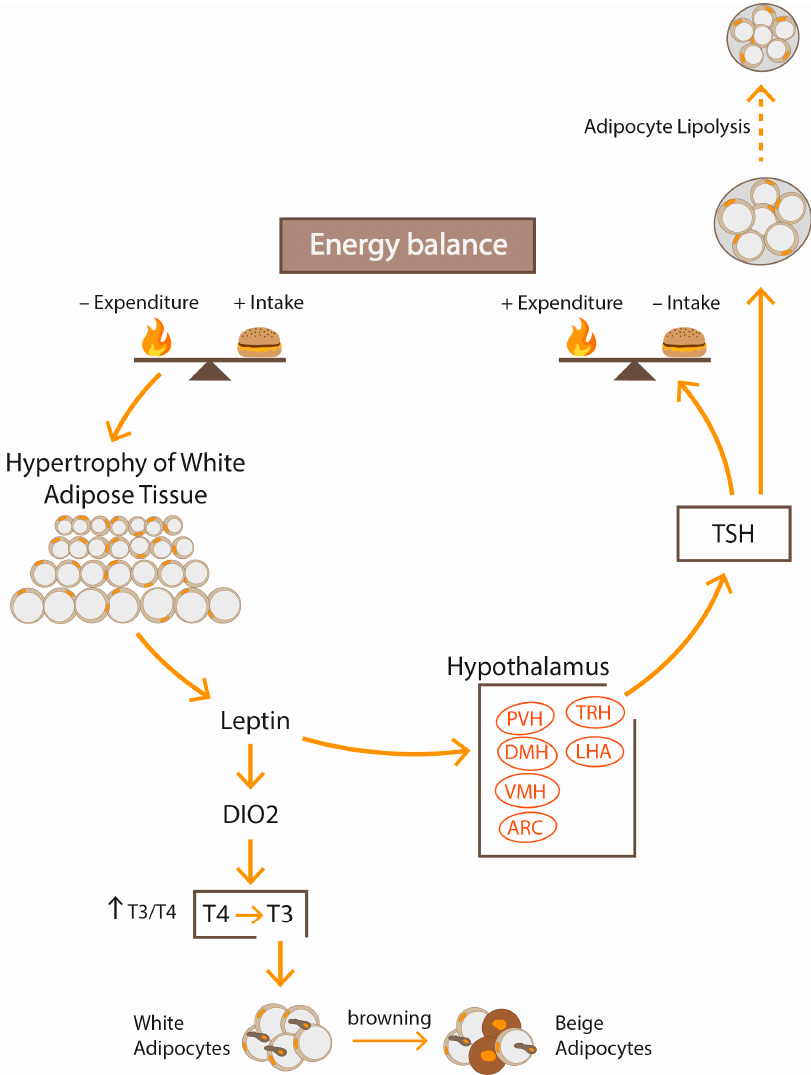
Figure 3. In conditions of excessive caloric supply, leptin activates TRH expression and then synthesis of TSH and THs. It suppresses appetite and promotes energy expenditure by increasing lipolysis and thermogenesis. In obese people, leptin can activate DIO expression and can increase conversion of T4 to T3. THs play a role in the browning of adipose tissue.